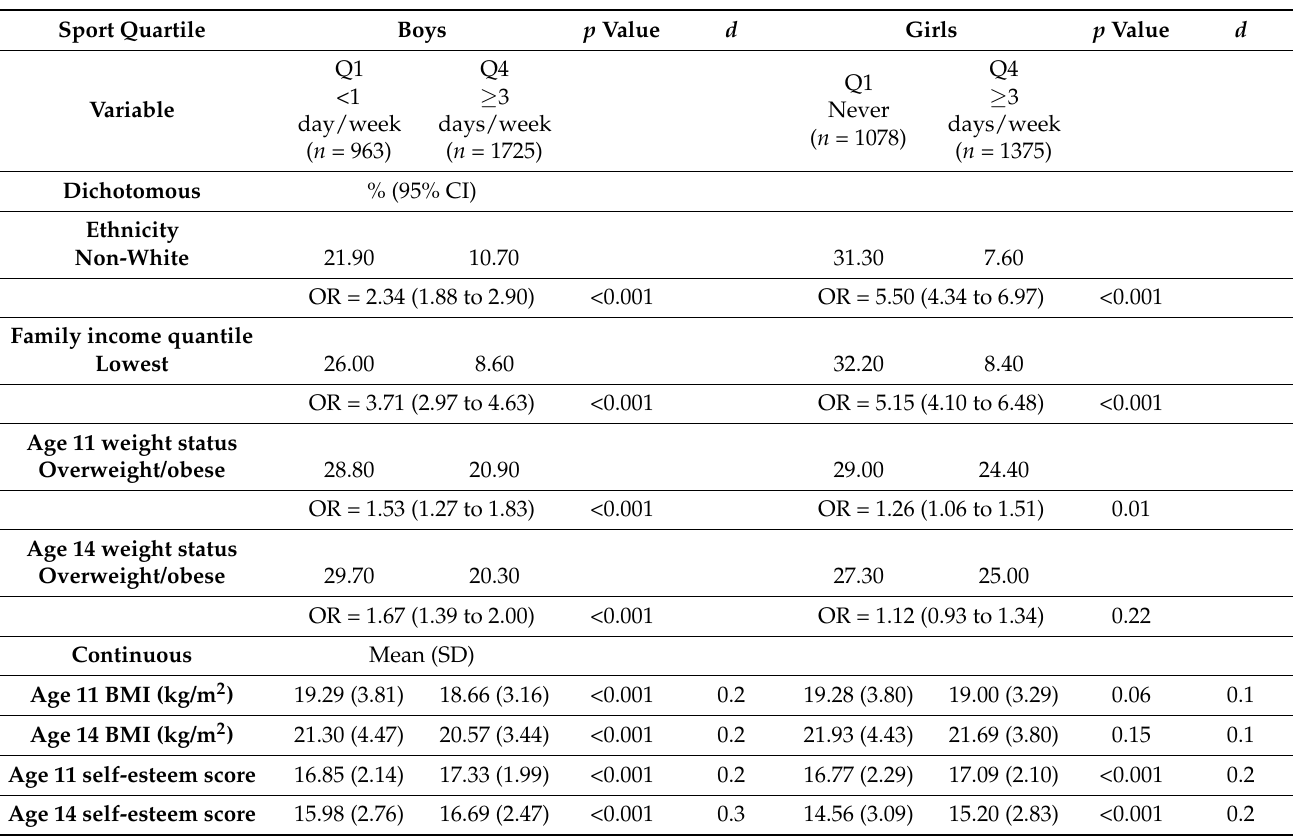
Table 2. Gender-specific Q1 and Q4 sport participation quartile differences in dichotomous and continuous variables.